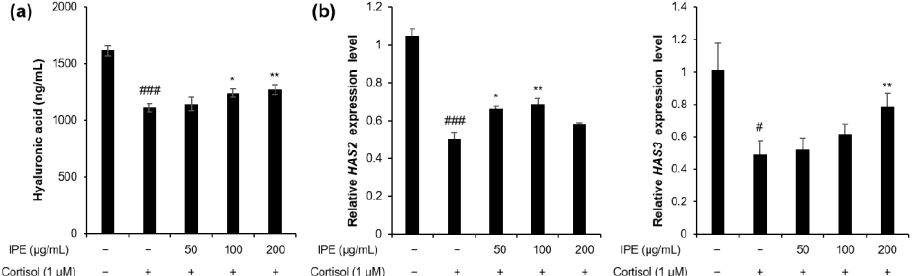
Figure 3. Effects of IPE on hyaluronic acid (HA) synthesis in cortisol-exposed HaCaT cells. Cells were pretreated with IPE (50, 100, and 200 µ g/mL) for 1 h and, then, exposed to cortisol (1 µ M) for 48 h. ( a ) Enzyme-linked immunosorbent assay of HA level in the culture supernatant of HaCaT cells. ( b ) Real-time quantitative reverse-transcription polymerase chain reaction for determining the relative expression of HAS2 and HAS3 . # p < 0.05, ### p < 0.001 compared to the control that was not exposed to cortisol; * p < 0.05, ** p < 0.01, compared to the cortisol-exposed